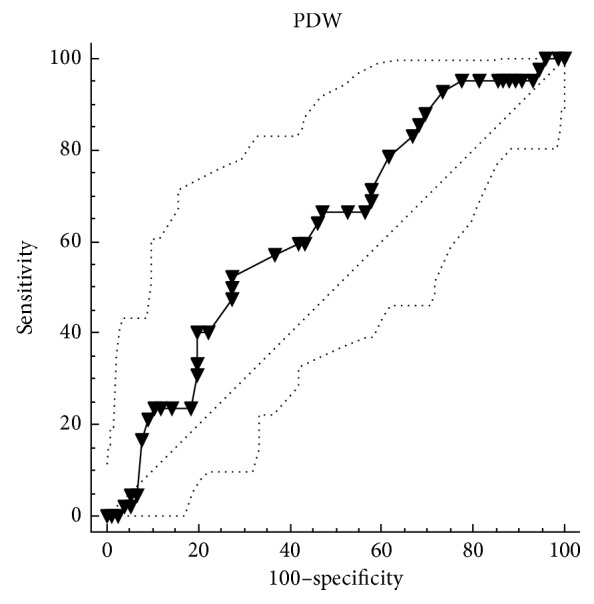
Optimized cutoff value was determined for the PDW using the ROC curve analysis.